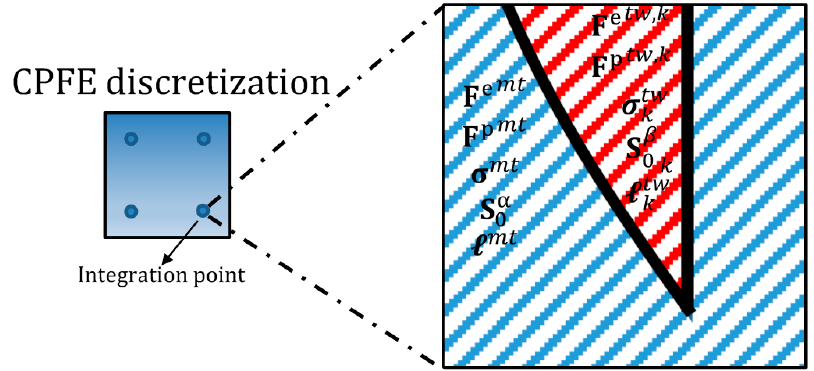
Figure 12. A partially twinned material point in the CPFE framework (After Yaghoobi et al. [9]). Yaghoobi et al. [9] calibrated the model using the uniaxial experimental data of extruded ZK60A Mg alloy presented by Wu [107] (Figure 13). The predictions of the modeled cyclic response of the ZK60A alloy along the extrusion direction were compared with the experimental data by Wu et al. [17] and Wu [107]. Yaghoobi et al. [9] further studied the cyclic response of ZK60A by comparing the predicted twin variation versus the normalized intensity of the { 0002 } diffraction peak along the longitudinal direction measured by Wu et al. [35] and Wu [107]. The result showed that not only can the multiscale TDT CPFE framework successfully capture the cyclic stress-strain response of the ZK60A (Figure 14), it can also capture the deformation twinning and detwinning during the cyclic loading (Figure 15). Furthermore, Yaghoobi et al. [9] showed the evolution of predicted basal ( 0001 ) pole figures at strains of ε = ± 1.2% (Figure 16). It was shown that the deformation twinning resulted in the reorientation of the basal pole, which intensifies in the basal { 0002 } peak in the loading direction at max compressive strains of ε = − 1.2% (Figure 16b,d). On the other hand, the detwinning mechanism removed the increased basal { 0002 } peak intensity at a max tensile strain of ε = 1.2% (Figure